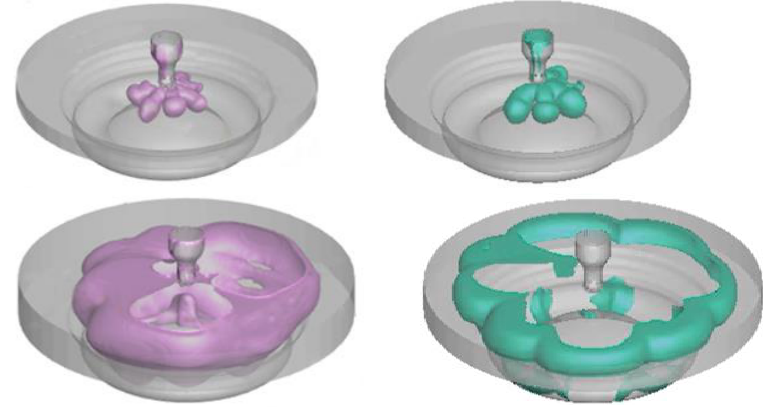
Figure 2. Initiation and development of the flame in the main chamber.